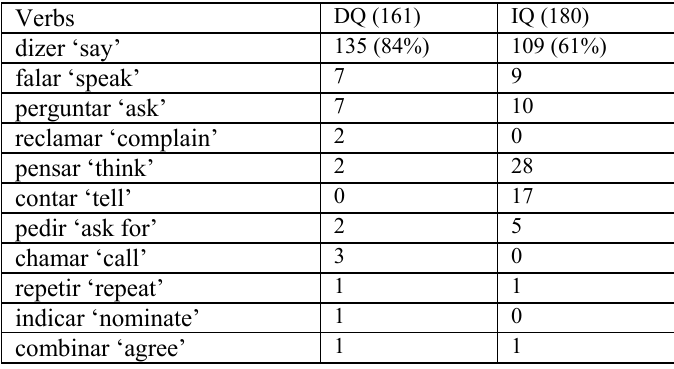
Table 1: Verbs of reported speech and